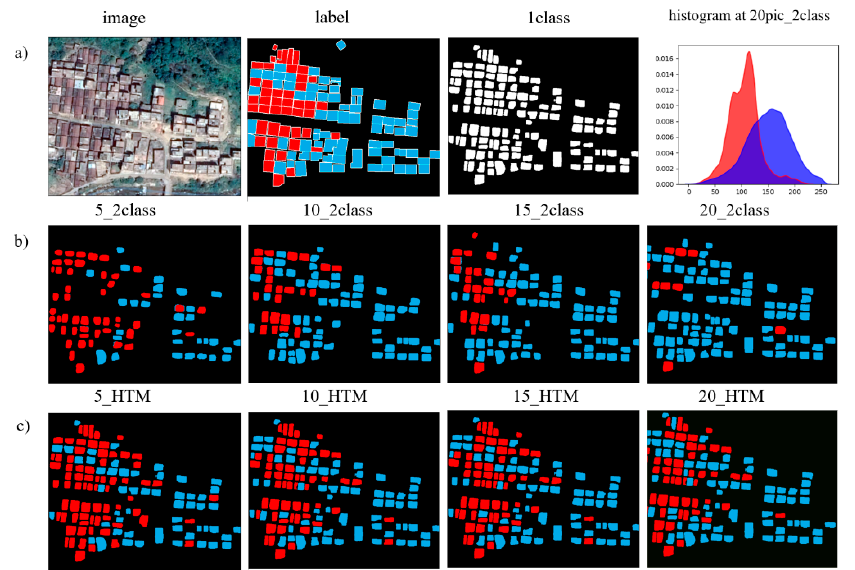
Figure 4. The result comparison of Site 1 between the baseline Mask R ‐ CNN model and the HTMask R ‐ CNN framework. ( a ) the satellite image from the test set, the second column shows the annotations, the third column shows the result of one ‐ class model (R1), and the fourth column shows the grayscale histograms of the new and old building footprints from R2 when training images = 20. ( b ) the result of the two ‐ class model (R2), with incremental training samples from 5 to 20. ( c ) the result of the HTMask R ‐ CNN framework (R3) with incremental training samples.